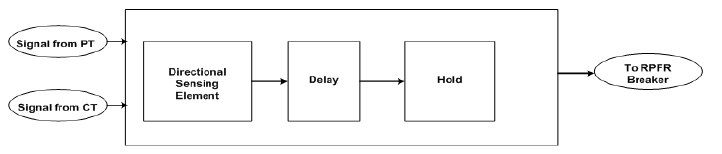
Figure 10. Basic block diagram of an RPFR.